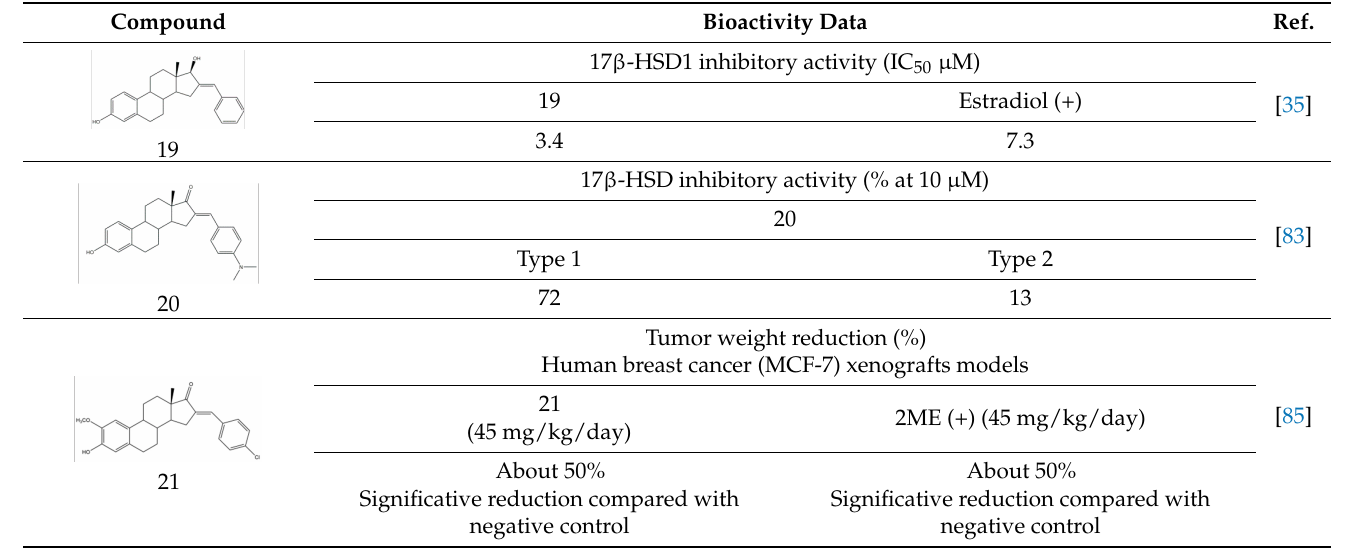
Table 3. The most active 16 E -arylidenoestrone and -estradiol derivatives. Positive controls, when shown, are identified by (+)